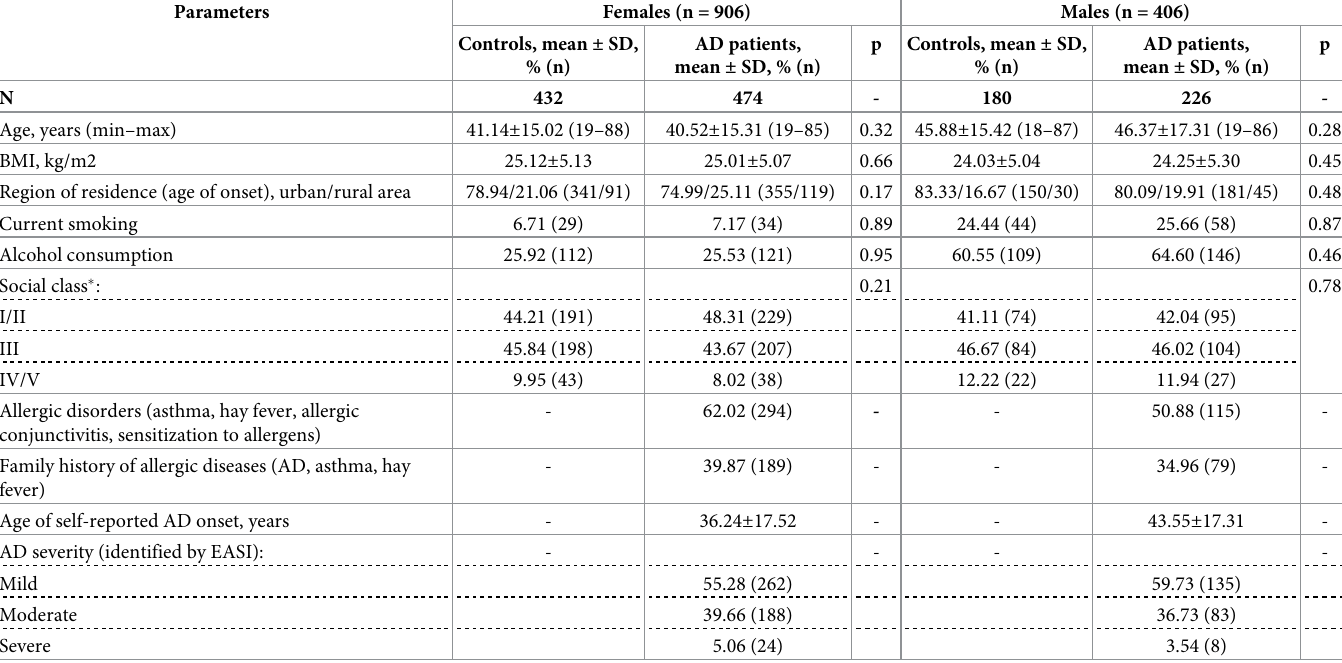
Table 1. Phenotypic and clinical characteristics of the study participants.